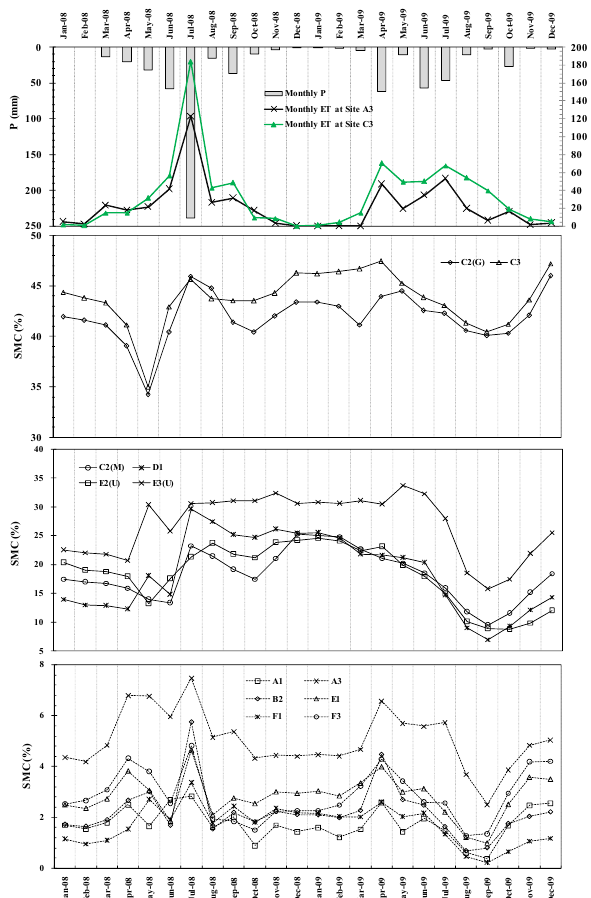
Fig. 3. Monthly soil moisture content (SMC) at the experiment sites (Table 2) and monthly areal precipitation (P) and evapotranspiration (ET) at site C3 and A3. Site A1, A3, F1 and F3 are located in the sandy dunes (high altitude, 186.2 to 200.3 m); site B2, E1, E2(U) and E3(U) are located in the transitional zones (medium altitude, 185.8 to 190.7 m); and site C2(G), C2(M), C3 and D1 are located in the meadows lands (low altitude, 188.6 to 189.5 m).